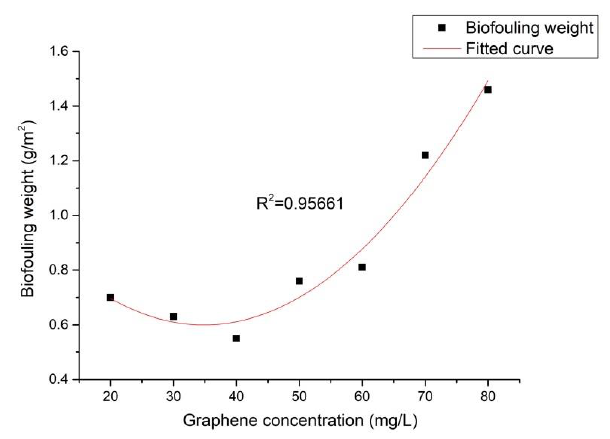
Figure 5. Effect of graphene concentration on the weight of the iron bacteria biofouling.